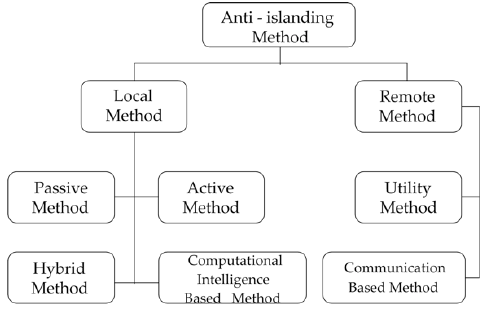
Figure 2. Classification of anti-islanding method.